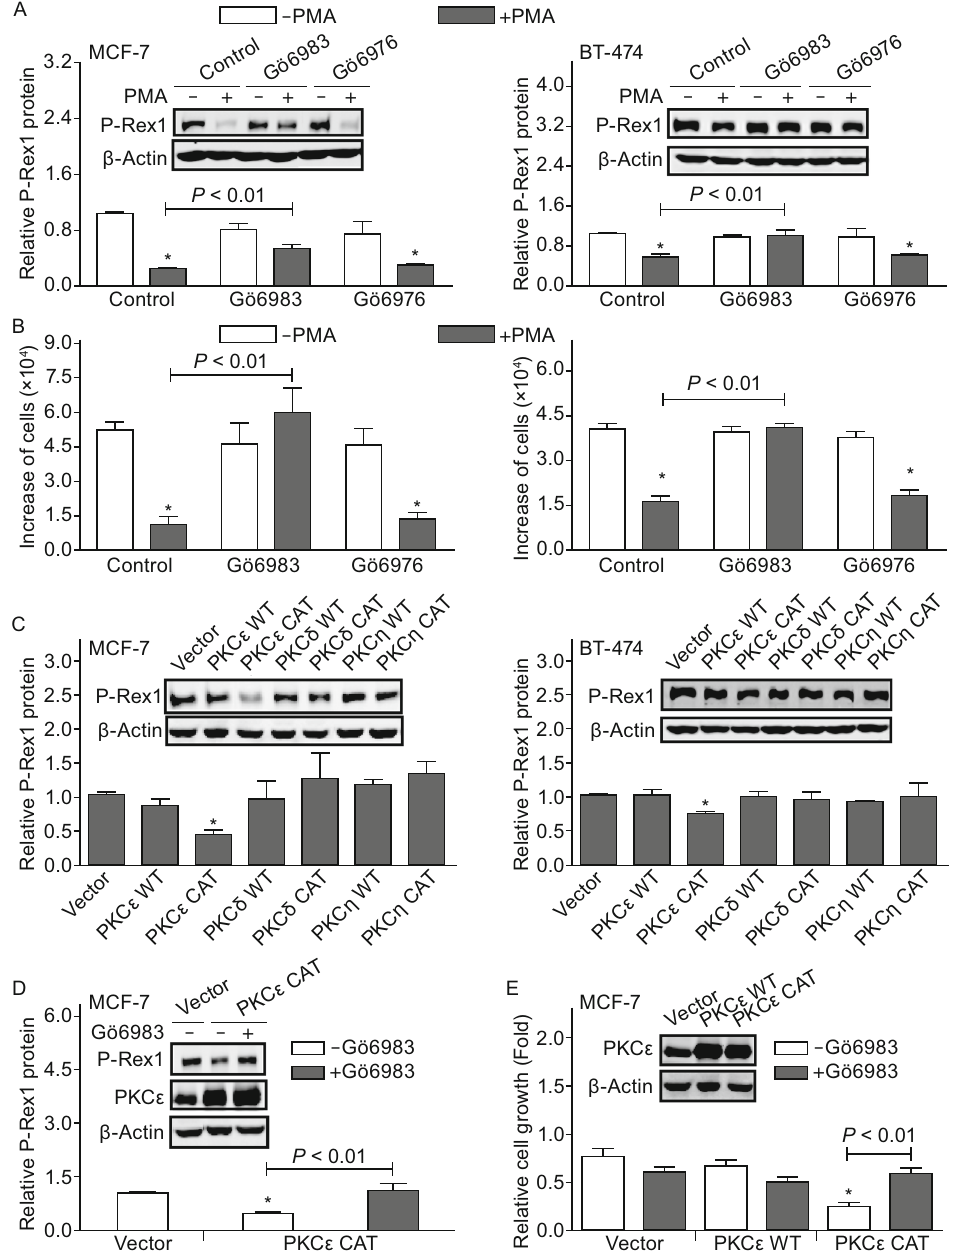
Figure 2. PKC ε activation contributes to PMA suppression of breast cancer cell growth through P-Rex1 down-regulation . The general PKC inhibitor Gö6983 (2 µmol/L), but not the conventional PKC isoform inhibitor Gö6976 (100 nmol/L), attenuated PMA (10 ng/mL) suppression of P-Rex1 expression (A) and breast cancer cell growth (B). (A) Western blot analysis of P-Rex1 expression. Data are means ± SEM ( n = 3) with * P < 0.01 compared to cells without PMA treatment. (B) Cell growth assay. Cells were cultured in the presence or absence of PMA for 48 h (MCF-7) or 72 h (BT-474). Data are means ± SEM ( n = 5 of duplicates) with * P < 0.01 compared to cells without PMA treatment. (C) Expression of PKC ε constitutively active form (CAT), but not PKC ε wild-type (WT), PKC δ or PKC η WTand CAT mutant, down-regulated P-Rex1 expression in MCF-7 and BT-474 cells. Data are means ± SEM ( n = 3) with * P < 0.01 compared to cells transfected with vector. (D) Gö6983 (2 µmol/L) attenuated PKC ε CAT-induced down-regulation of P-Rex1 expression in MCF-7 cells. (E) Expression of PKC ε CAT, but not its WT, suppressed MCF-7 cell growth, which is blocked by treatment with Gö6983 (2 µmol/L). Data are means ± SEM ( n = 3 of duplicates) with * P < 0.01 compared to cells transfected with vector. Insets: Representative Western blot images of P-Rex1, PKC ε , and β -actin protein expression in breast cancer